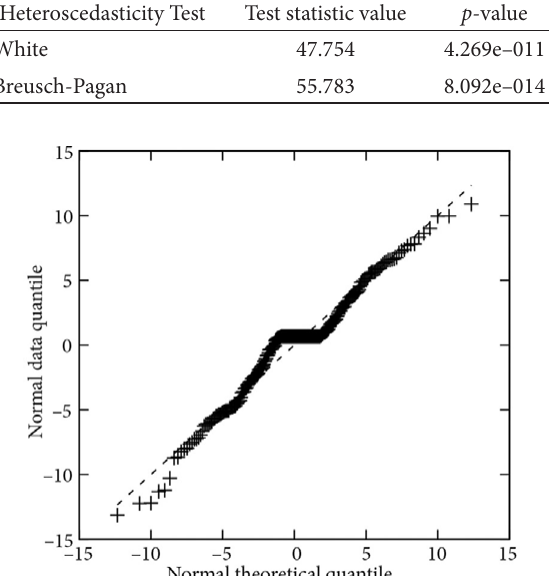
Fig. 5. Graph of residuals by observation number